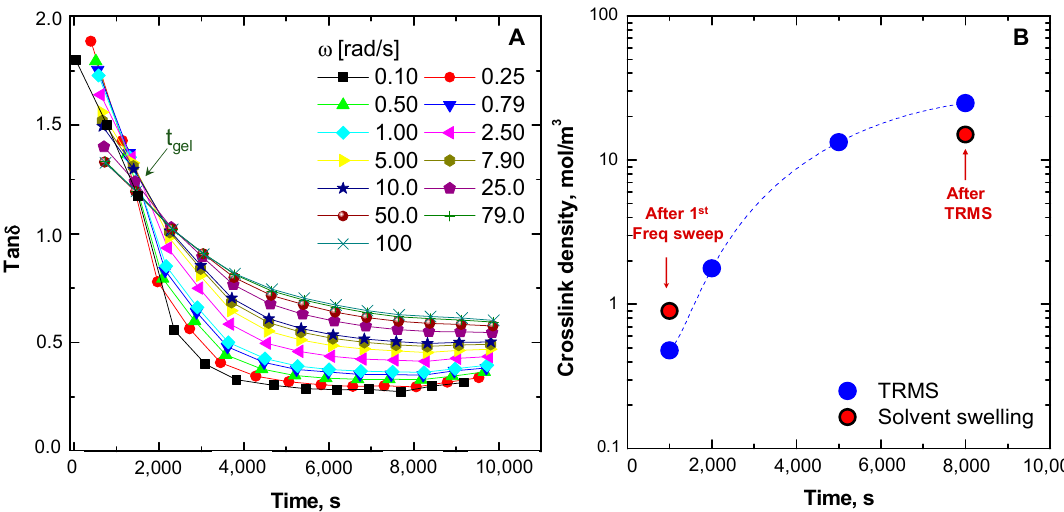
Figure 6. Evolution of tan δ during the TRMS tests ( A ) and crosslink density (from TRMS data and from solvent-swelling experiments) as a function of time ( B ).